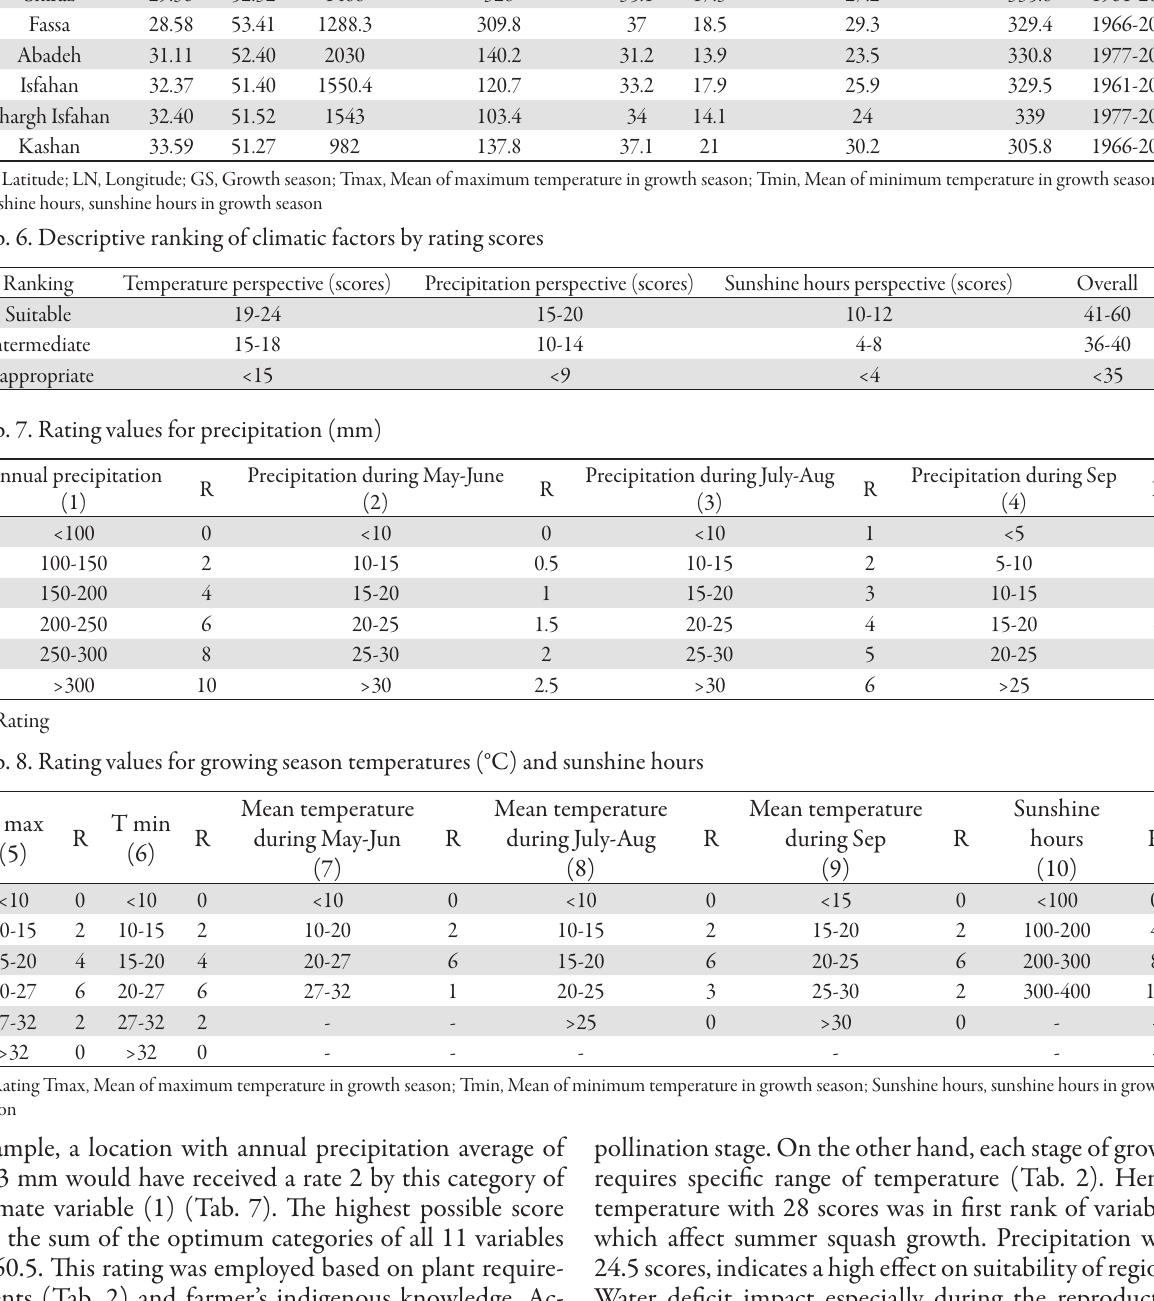
Tab. 5. Climatic features of various study locations in Fars and Isfahan region Location